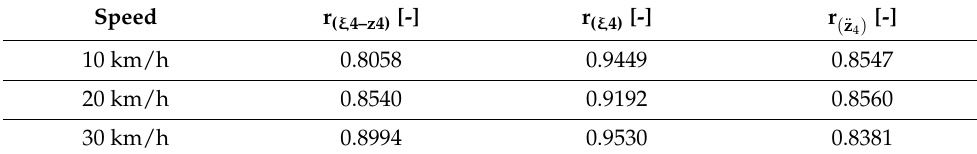
Table 2. Pearson correlation coefficient between the simulation and the experiment results. Table 3. Error of the highest value between the simulation and the experiment results.